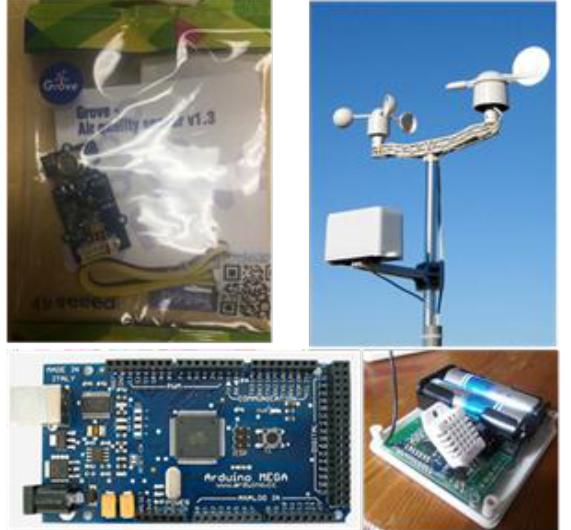
Figure 9: Sensors used: from left to top air quality sensor, weather station, Arduino system, humidity and temperature.